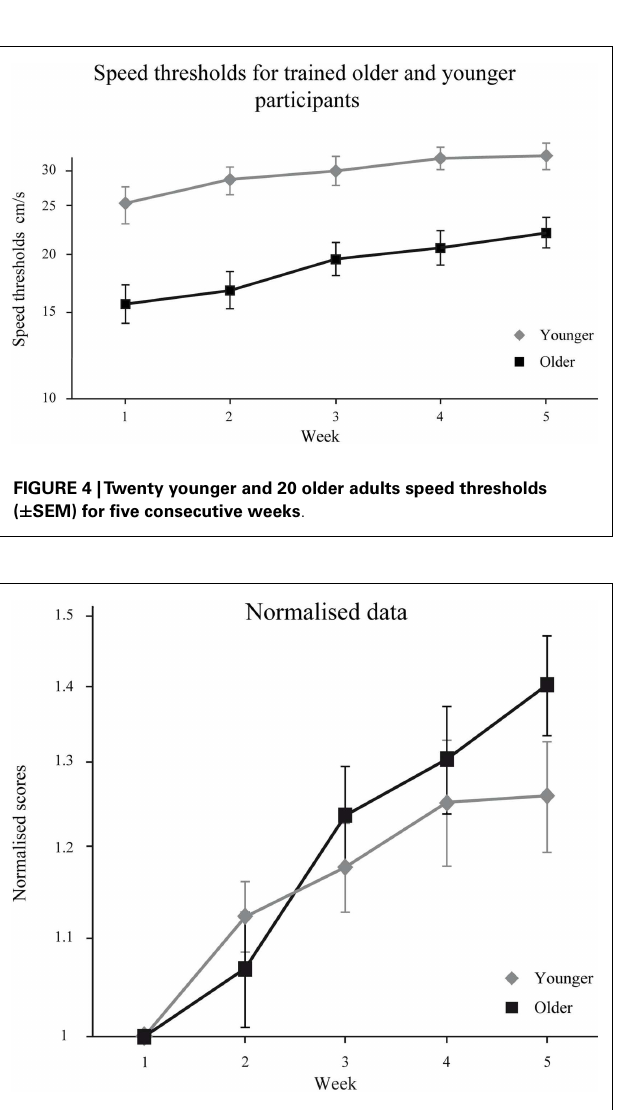
FIGURE 5 | Normalized speed thresholds ( ± SEM) for 20 younger and 20 older adults . (Ratio of speed threshold relative to week